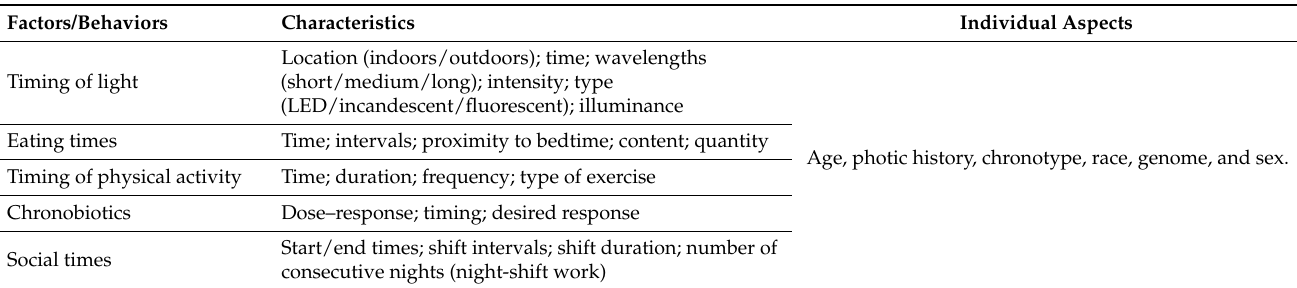
Table 1. Circadian hygiene factors/behaviors and their